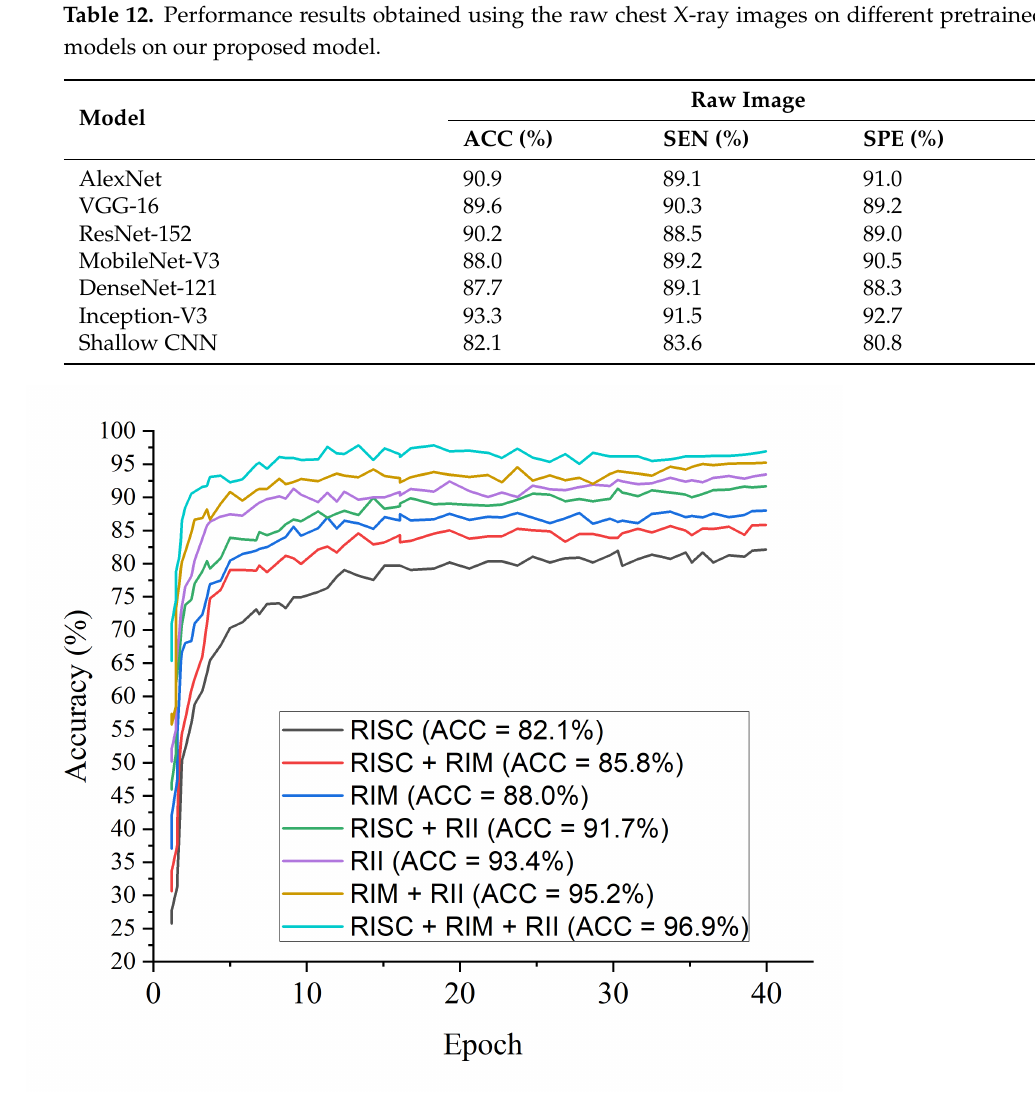
Figure 16. Accuracy results using the raw chest X-ray